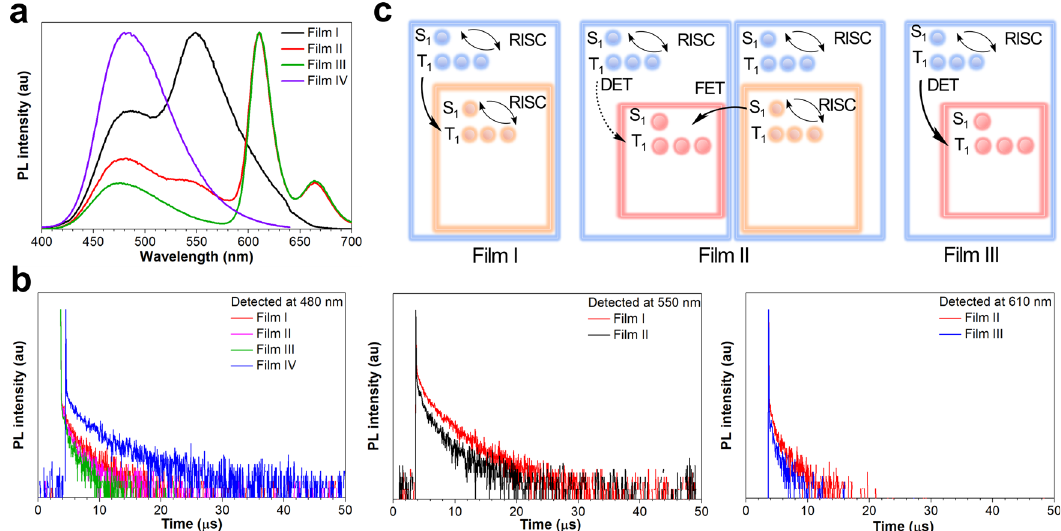
Fig. 5 | Mechanism study of sensitizing process. a PL spectra of fi lms I~IV. b Transient PL decay curves of fi lms I – IV. c Mechanism illustration of exciton behaviorsin fi lmsI – III,inwhichblue,orangeandredrectanglesrepresentTCP-BP-